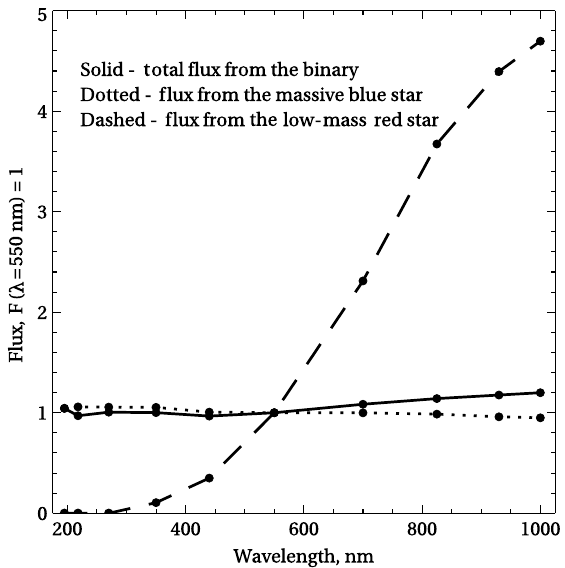
Fig. 2. Example of spectral energy distribution (SED) for a binary star. The dashed and dotted lines are SEDs of the components, while the solid line represents the total